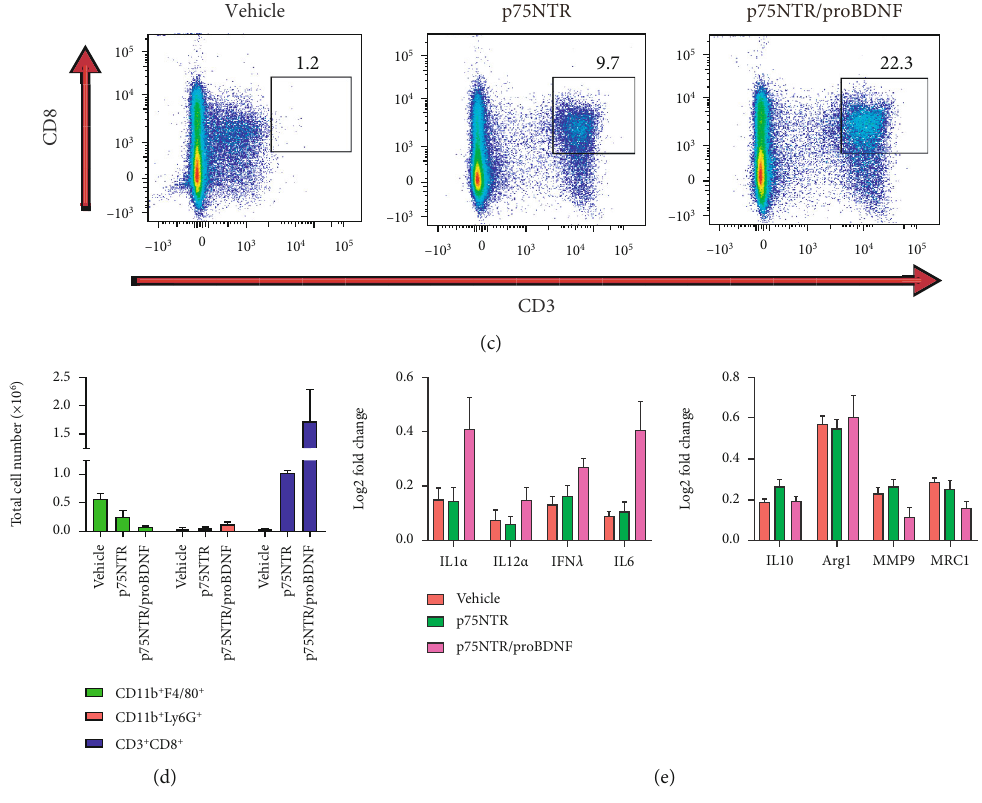
Figure 5: p75NTR/proBDNF overexpression modulates the recruitment of adaptive and innate immune cells. (a) Representative gating (FlowJo) and quantitation of CD45 + CD11b + F4/80 + cells (macrophages) and CD45 + CD11b + Ly6G + cells (neutrophils) in normal skin, p75NTR BCC, and p75NTR/proBDNF BCC. (b – d) Representative gating (FlowJo) and quantitation of CD45 + CD3 + CD8 + cells (CD8 T cells) in normal skin, p75NTR BCC, and p75NTR/proBDNF BCC. (e) In human samples, quantitation of cytokines and chemokines of M1 and M2 (macrophages) in normal skin and p75NTR/proBDNF BCC. In a syngeneic mouse model of BCC, quantitation of cytokines and chemokines of M1and M2 (macrophages) in normal skin and p75NTR/proBDNF